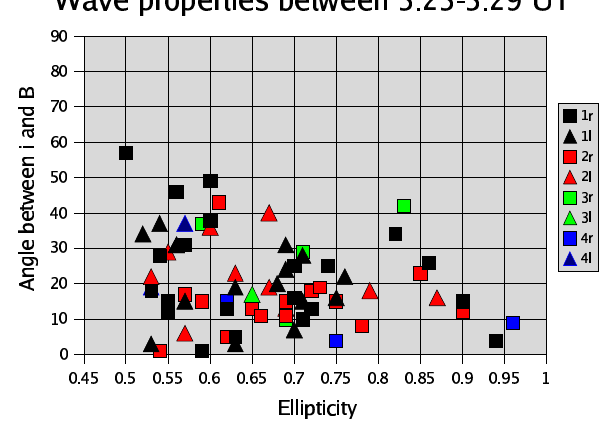
Fig. 11. The ellipticity of the waves between 05:25 and 05:29 UT as a function of the angle between the minimum variance direction and the ambient magnetic field. Squares and triangles represent right- hand and left-hand polarized waves, respectively, as seen in 1–2-s intervals at each of the spacecraft. The usual colour coding is